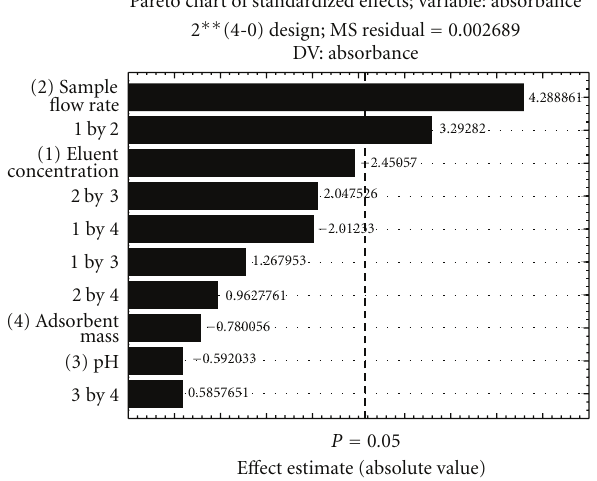
Figure 3: Pareto chart obtained from the optimization study of the variables, with their significance, for the preconcentration of Zn(II) using activated carbon obtained from Moringa oleifera husks as the sorbent and FAAS.